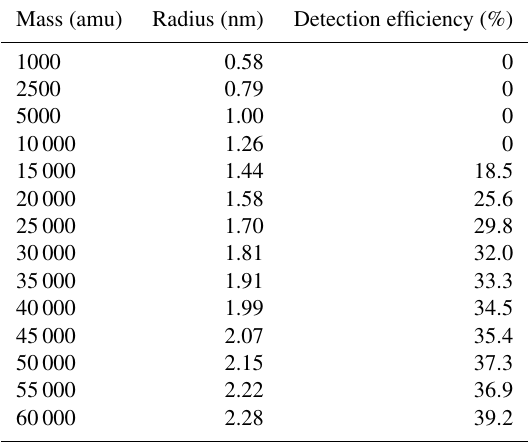
Table A1. Particle detector detection efficiency p(r) at